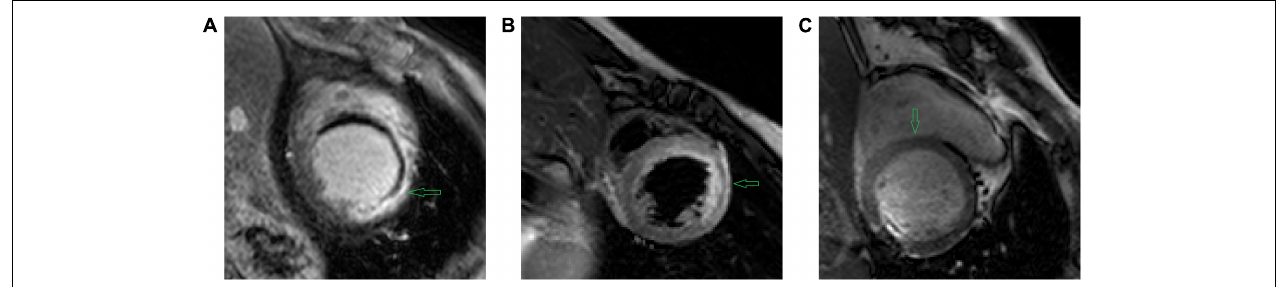
FIGURE 3 | Example images using different CMR sequences acquired by (A) LGE CMR (B) T2 CMR (C) bSSFP CMR. As denoted by the green arrows, we can see (A) LGE CMR accentuates the scar tissue by high intensities on the images; (B) T2 CMR accentuates myocardial oedema by high intensities on the image; and (C) bSSFP CMR shows the distinct endo- and epi-cardial boundary of the myocardium clearly on the image. Image source: (A–C) extracted from the MS-CMR open challenge dataset (MS-CMR Challenge, 2019).